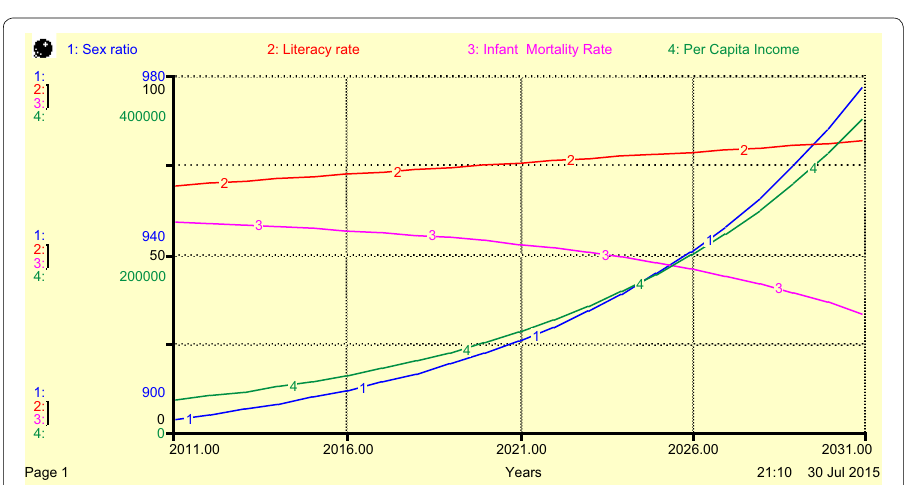
Fig. 18 Perceived projected sex ratio, literacy rate, infant mortality rate, and per capita